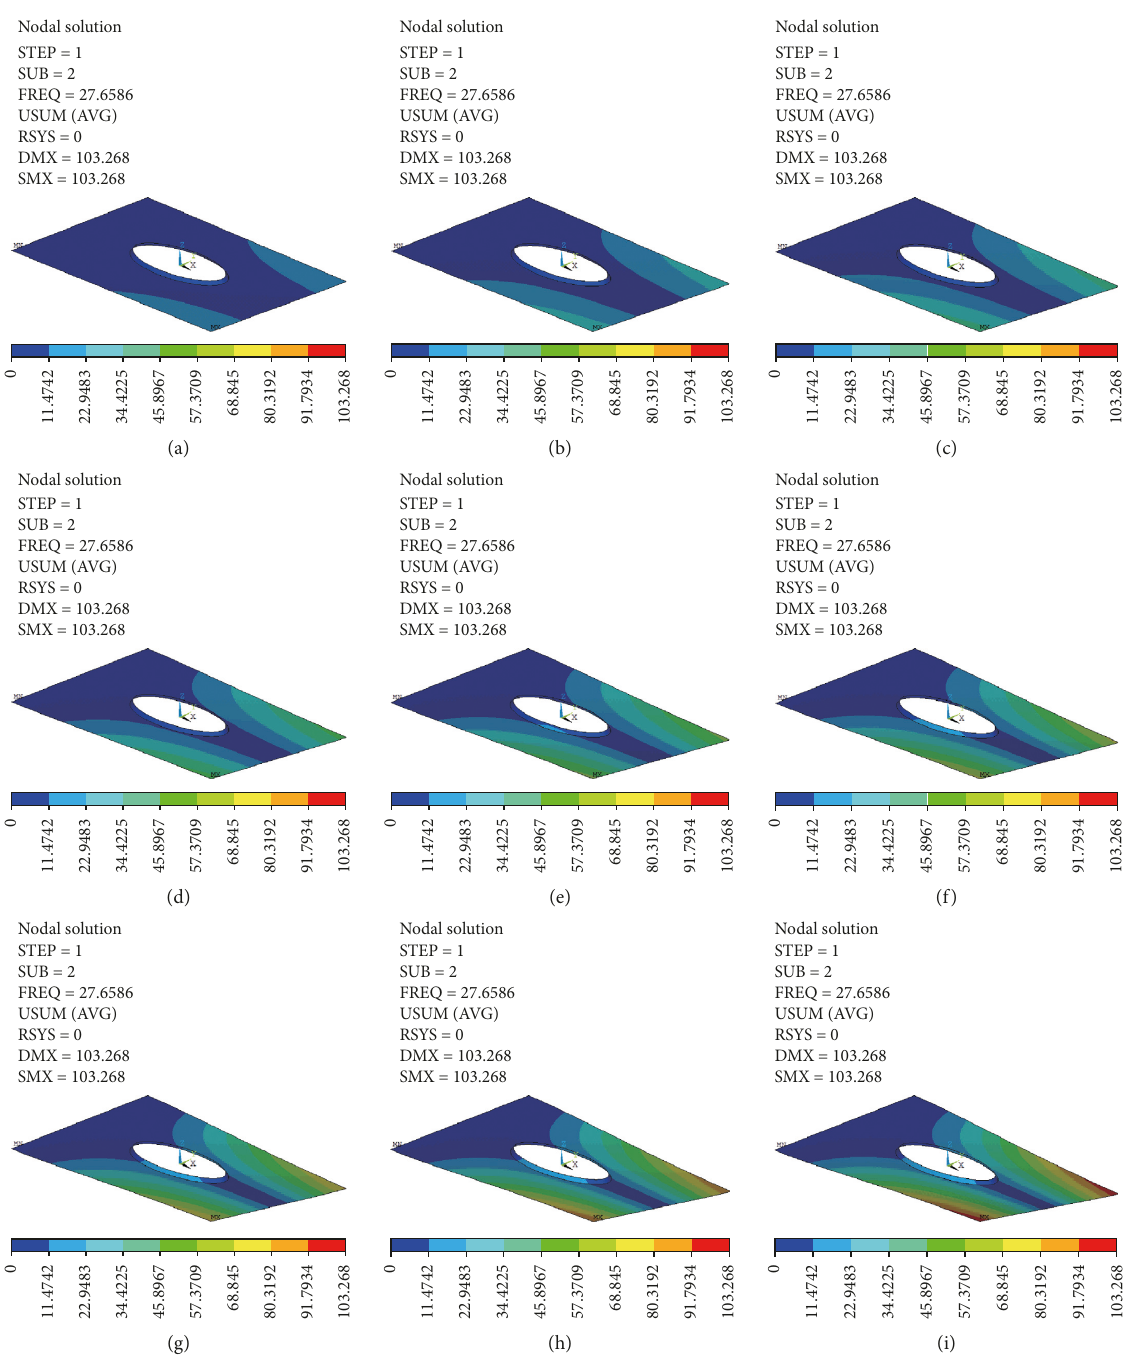
Figure 3: Oscillatory process of the plate for the second frequency in CFFF. (a) Time (e) Time 0.25. (f) Time (cid:31)